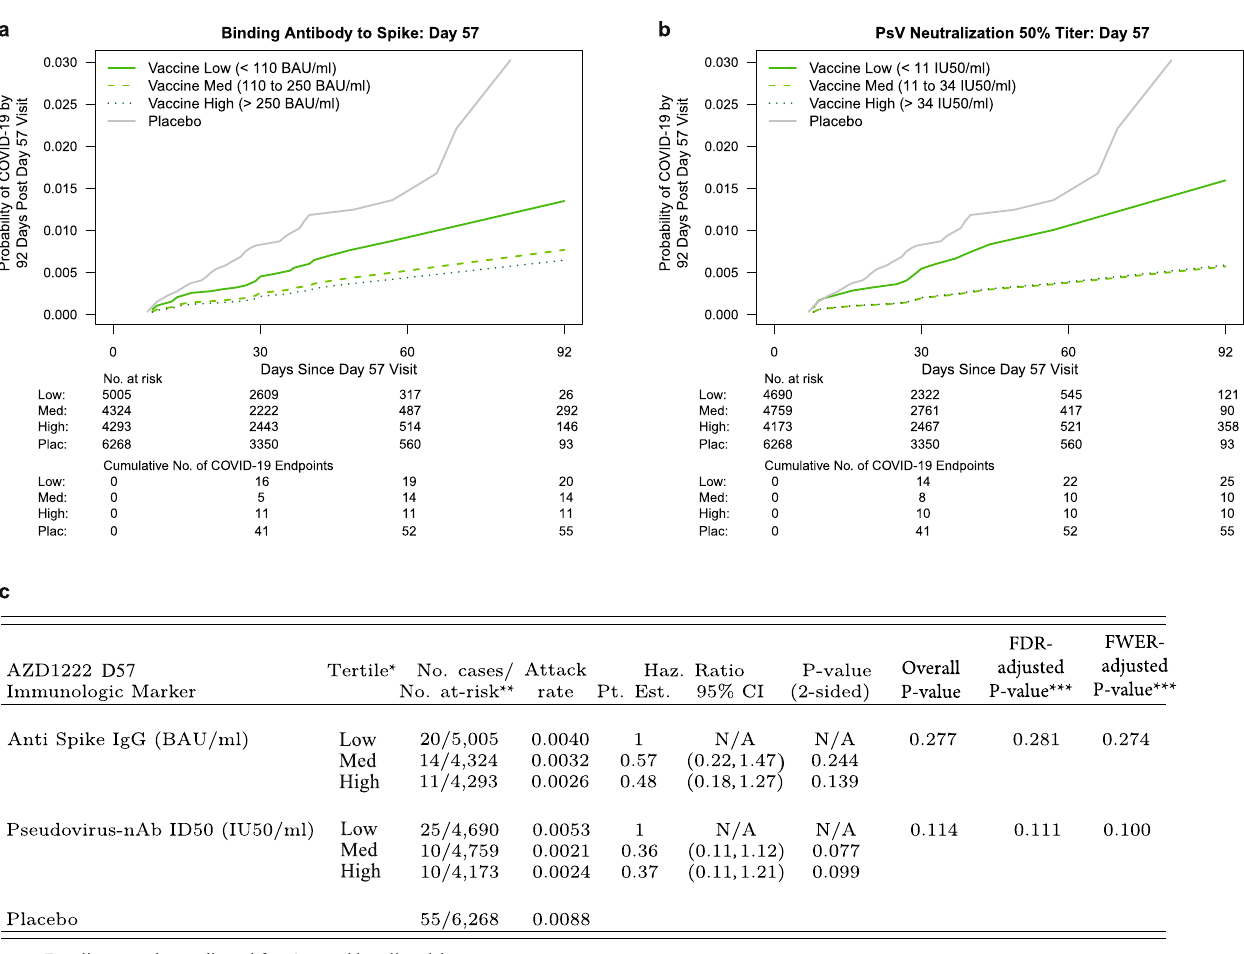
Fig. 3 COVID-19 risk by D57 antibody marker level in baseline SARS-CoV-2 negative vaccine recipients. Cumulative incidence of COVID-19 by Low, Medium, High tertile of D57 antibody marker level. a , c Anti-spike IgG concentration; b , c pseudovirus (PsV) neutralization ID50 titer. The overall P -value is from a generalized Wald-test p -value of the null hypothesis that the hazard rate is constant across the Low, Medium, and High tertile groups. The total number of cases across the Low, Medium, and High tertiles ( N = 45) for each antibody marker differs from the numbers in Table 1 and Fig. 1 ( N = 33, 22 for spike IgG, PsV-nAb ID50, respectively) because the 45 includes all vaccine breakthrough cases including those without D57 antibody marker 19 trials, providing clear replication of the correlates fi ndings. The distribution of spike IgG is highest and similar for the NVX- CoV2373 and mRNA-1273 vaccines, intermediate for the AZD122 vaccine, and lowest for the Ad26.COV2.S vaccine. The vaccine ef fi cacy curve is similar for the ChAdOx1 nCoV-19 and NVX- CoV2373 vaccines. The ChAdOx1 vaccine ef fi cacy curves are to the right of the Ad26.COV2.S vaccine ef fi cacy curve, suggesting that a lower IgG concentration may be required for the same level of vaccine ef fi cacy for the Ad26.COV2.S vaccine. Estimated vaccine ef fi cacy also increased with increasing nAb ID50 titer in each trial (Fig. 6b). The vaccine ef fi cacy curve is similar for the ChAdOx1 nCoV-19 and mRNA-1273 vaccines, suggesting that the same neutralizing antibody titer is connected to approximately the same degree of ef fi cacy of these vaccines.